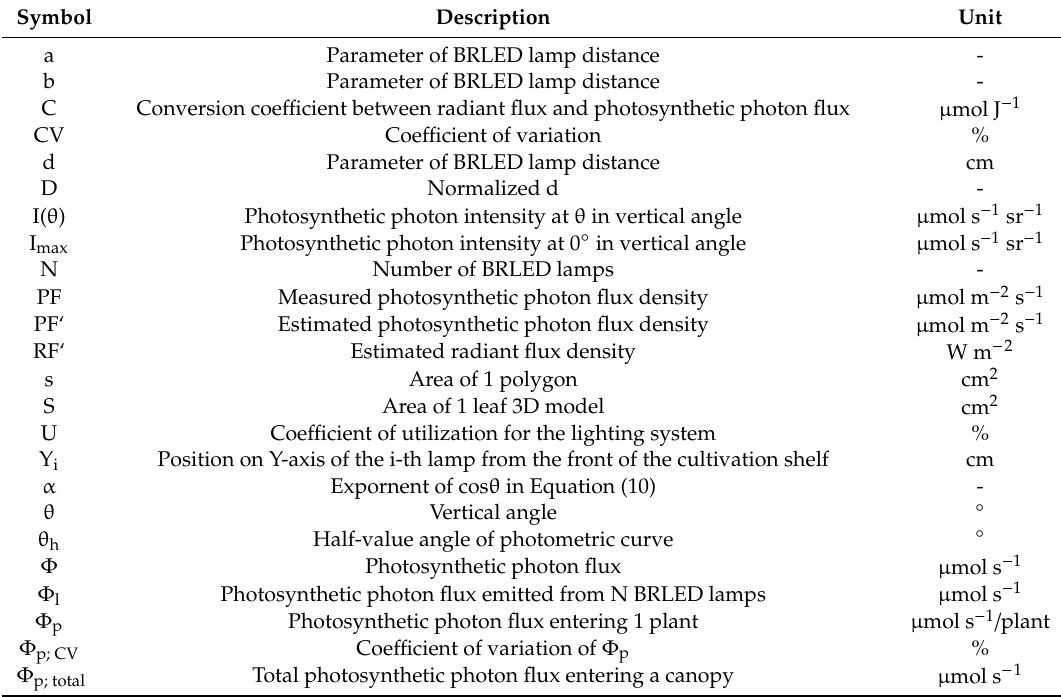
Table A1. List of symbols and these